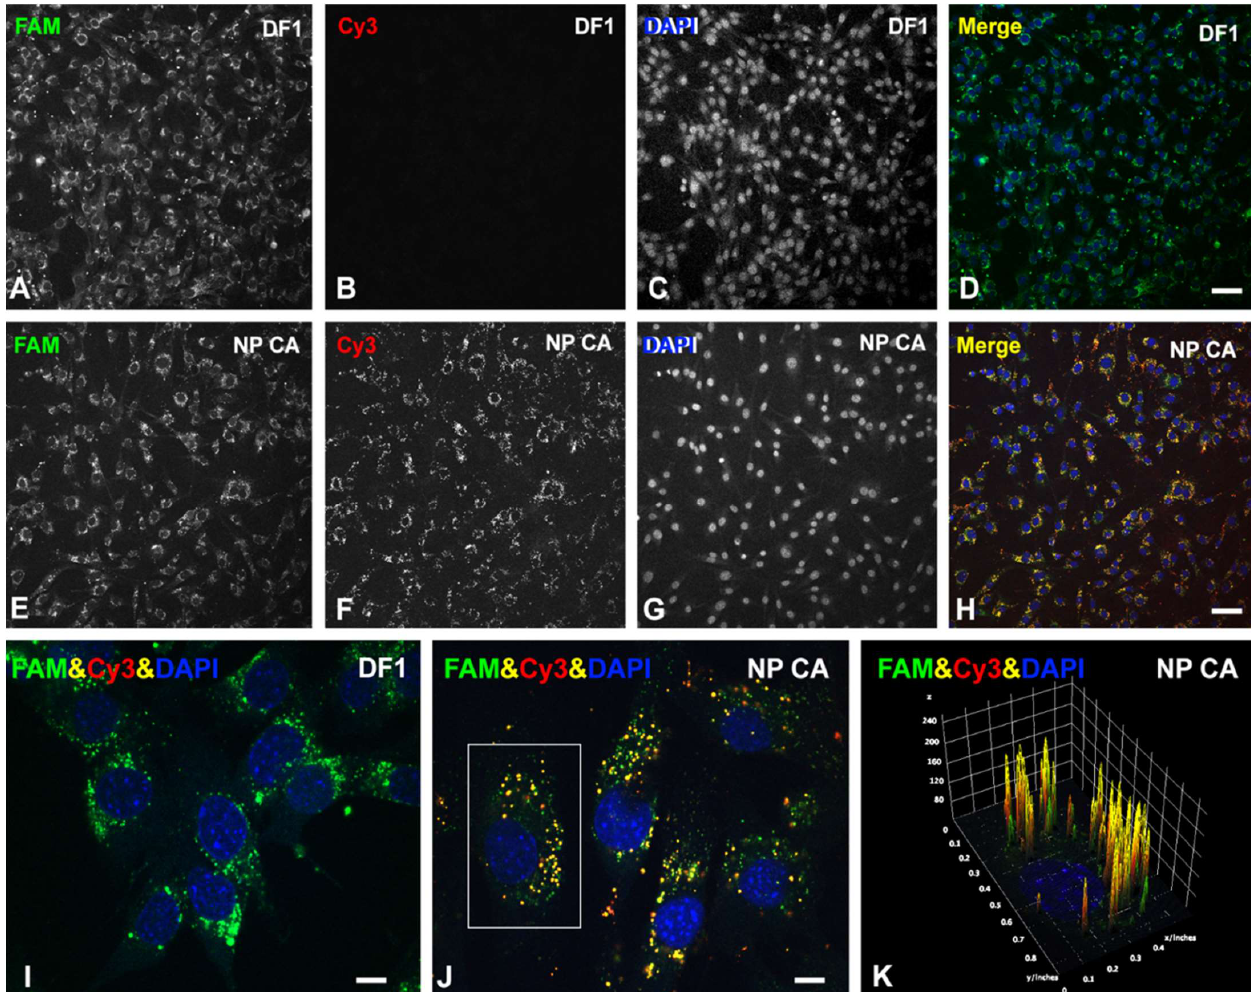
Figure 5. Confocal images of C2C12 cells showing the cellular uptake of a FAM-conjugated non- targeting GapmeR (FAM, green) achieved using either Dharmafect 1 (DF1) as RNA delivery liposomal-based methodology (DF1) ( A – D ) or by a muscle receptor-mediated mechanism with CA synthesized nanocomplex functionalized with the Cy3-conjugated specific A01B aptamer (Cy3, red) ( E – H ). Cells were fixed and counter stained with DAPI (blue) to visualize cell nuclei. ( I , J ) Higher magnification (100×) confocal images showing the cytoplasmic FAM-GapmeR accumulation, surrounding the cell nuclei, using both DF1 ( I ) and CA nanocomplexes ( J ). Note the strong colocalization of FAM-GapmeR with the Cy3-aptamer in yellow foci, corresponding to MSCD. ( K ) Fluorescence intensity analysis using 3D interactive surface plot from the Fiji software from the cell indicated in (( J ), white box). The graphical representation allows a clear visualization of intracellular FAM-conjugated Gapmers (green) and Cy3-conjugated Aptamer (red). Each yellow peak represents Gapmer/Aptamer (FAM/Cy3) colocalization in MSCD. Scale bars: 100 μm ( A – H ) and 15 μm ( I – J ).